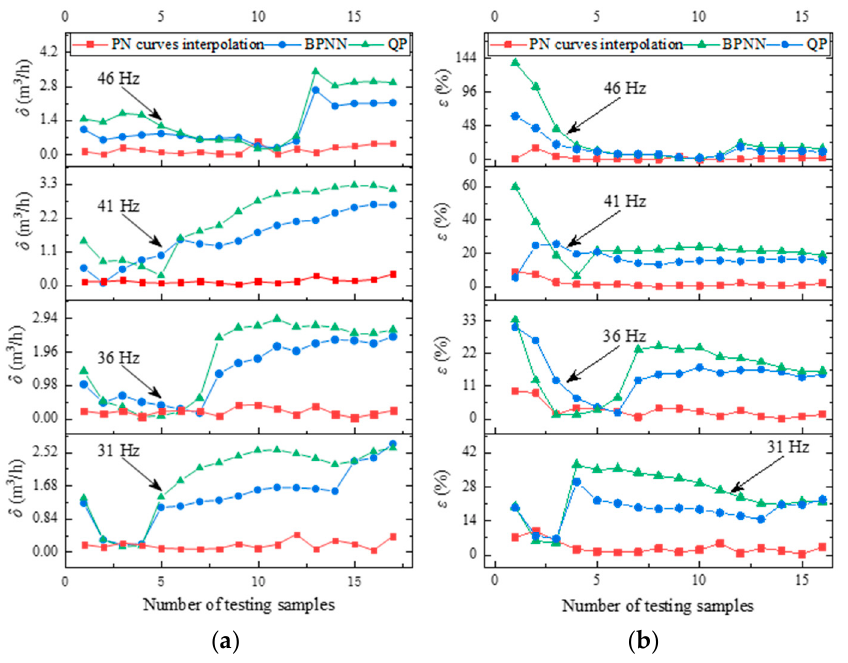
Figure 14. Errors of the three estimation methods: ( a ) absolute errors and ( b ) relative errors. Table 3. Error data of the three estimation